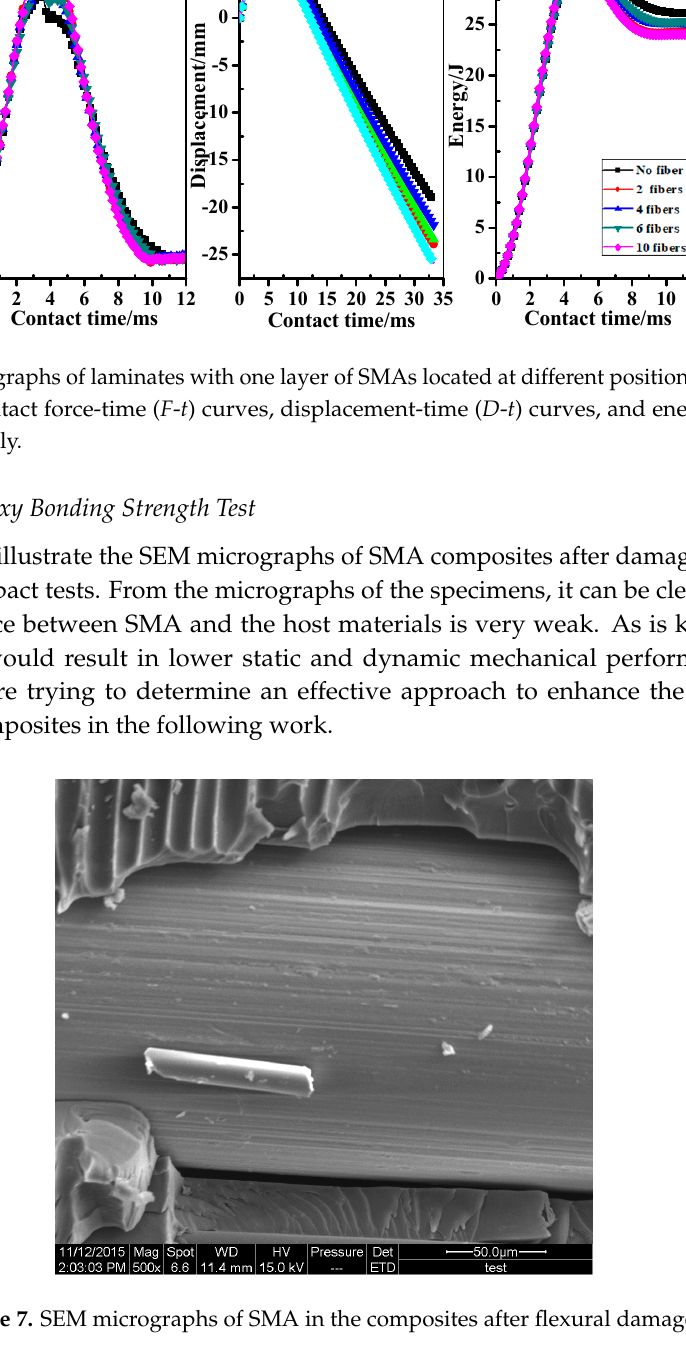
Figure 7. SEM micrographs of SMA in the composites after flexural damage.